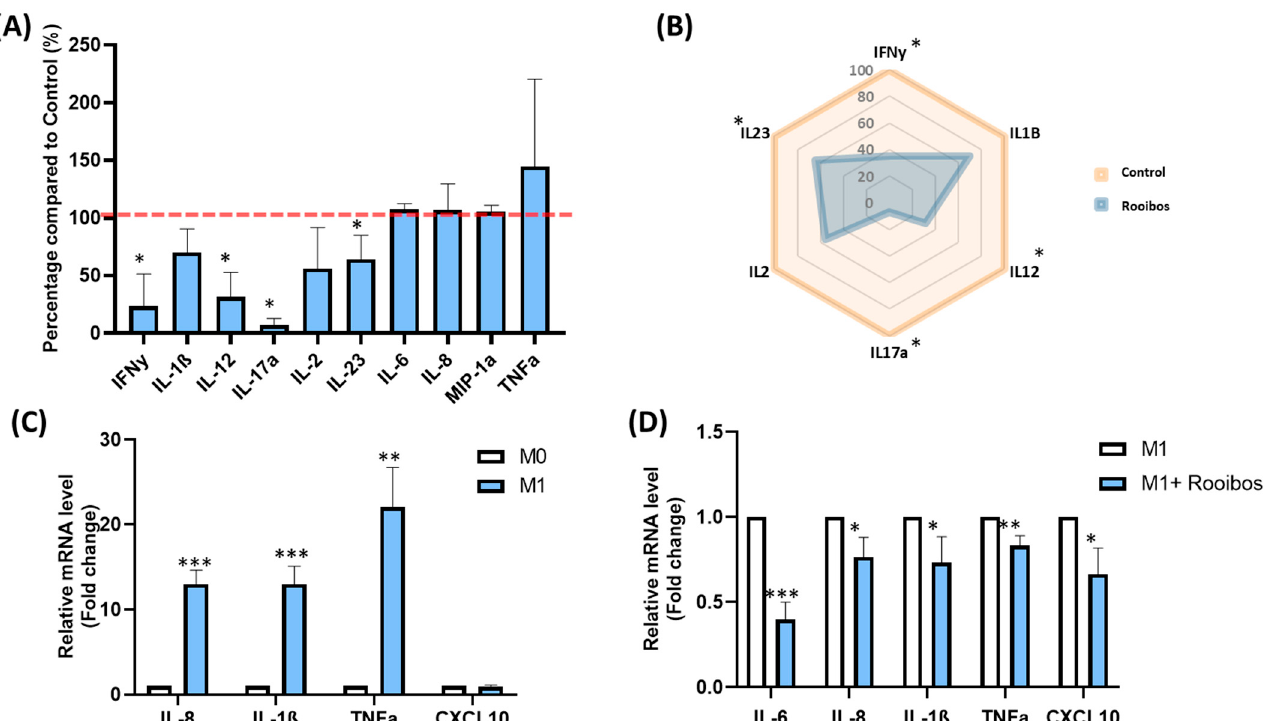
Figure 2. Impact of Rooibos extract on cytokines. ( A ) Measurement of ten pro-inflammatory cytokines secreted by PBMCs using Procarta-Plex™ Immunoassays. Cells were incubated with Rooibos extract (50 µg/mL) and stimulated with PHA (5 µg/mL) for 24 h. Data shown as mean ± SD; ( B ) summary of the overall effect of Rooibos extract on the main pro-inflammatory cytokines in PHA-stimulated PBMCs; ( C ) THP-1 macrophages were stimulated with 20 ng/mL IFN- γ + 100 ng/mL LPS as described in the Materials and Methods section, and the mRNA expression of IL-6 , TNF α , IL-1 β , IL-8 and CXCL10 was measured by qRT-PCR. β -Actin was used as an internal control. M0 macrophages were used as a control; ( D ) the mRNA expression of IL-6 , TNF- α , IL-1 β , IL-8 and CXCL10 was measured by qRT-PCR in cells treated or untreated with 50 µg/mL Rooibos extract, and stimulated with LPS/IFN- γ . β -Actin was used as an internal control. Untreated M1 macrophages were used as a control. All data represent the means of 3–5 replicates ± SD. * p < 0.05 , ** p ≤ 0.01, *** p ≤ 0.001 represent significant differences compared with the control.